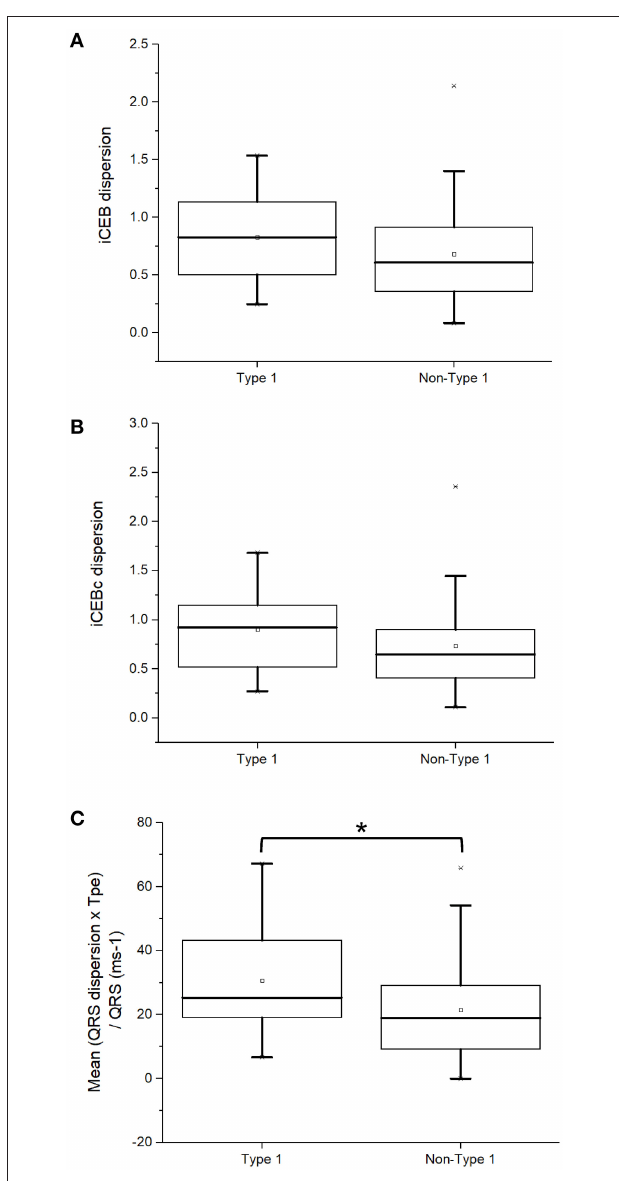
FIGURE 6 | iCEB dispersion (A) , iCEBc dispersion (B) , or (QRSd × T peak − T end )/QRS (C) in type 1 and non-type 1 Brugada syndrome patients. *Denotes significant difference between the two groups.